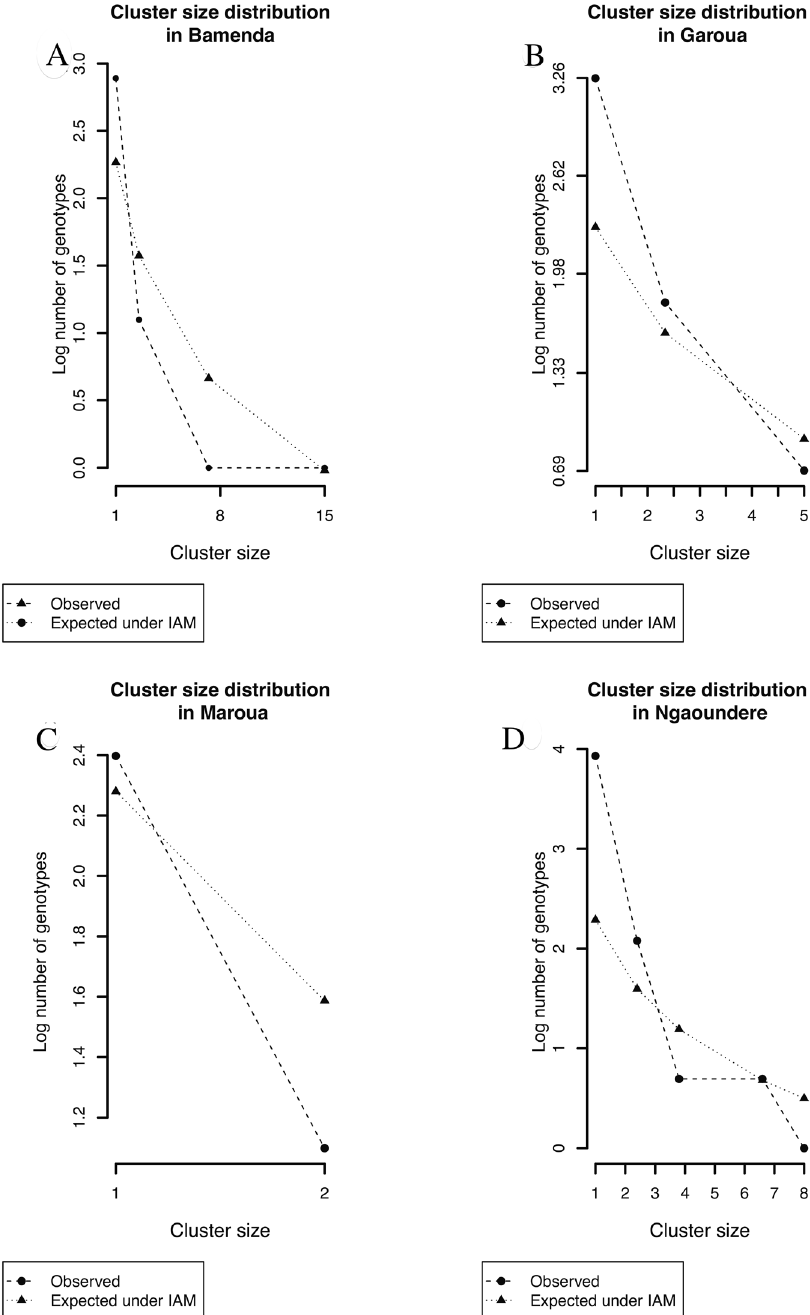
Figure 8. The distribution of the observed genotype cluster sizes (i.e. the number of times a particular genotype occurs at an abattoir) compared to what would be expected under the infinite allelic model (IAM) in the four Regional abattoirs in Cameroon. (A = Bamenda; B = Garoua; C = Maroua; D =